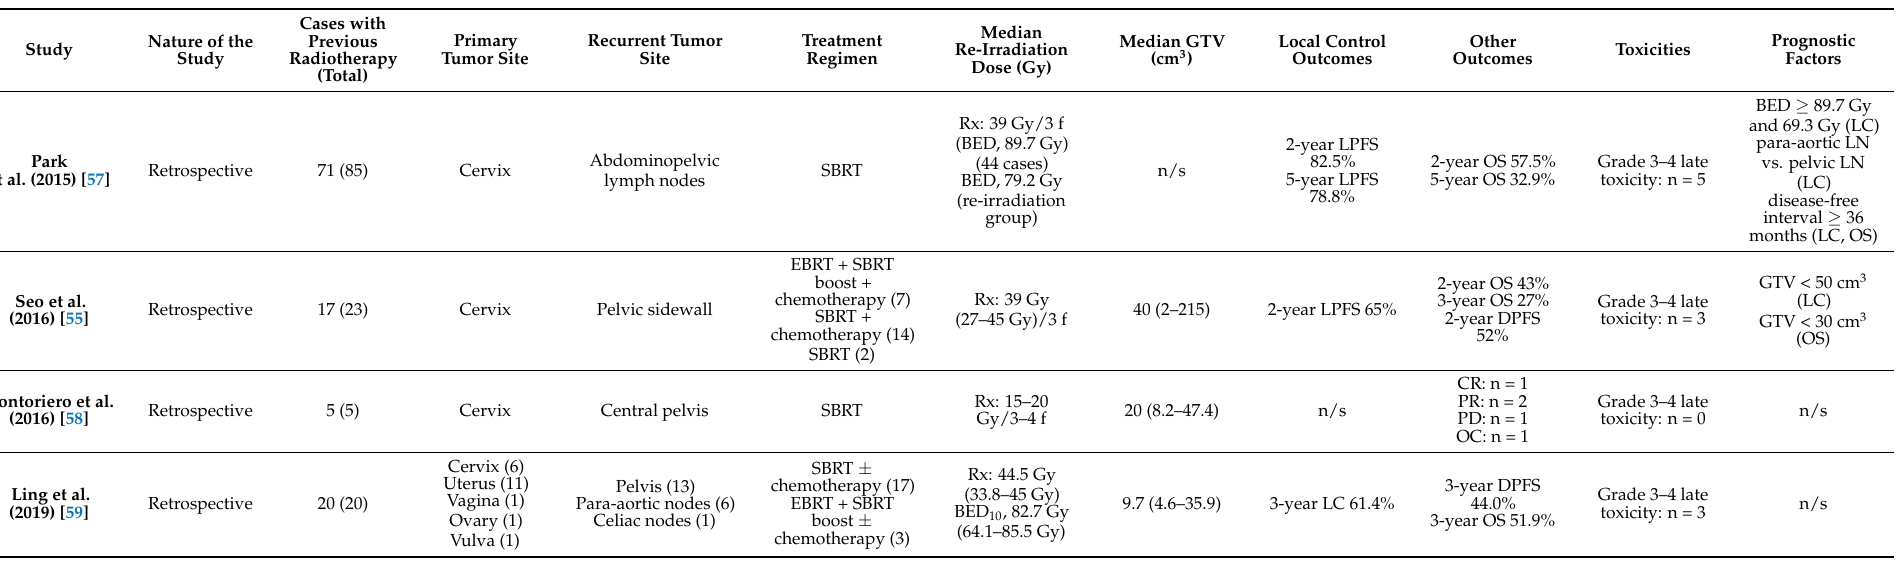
Table 3. Recent studies on re-irradiation with stereotactic body radiation therapy (SBRT) for recurrent cervical